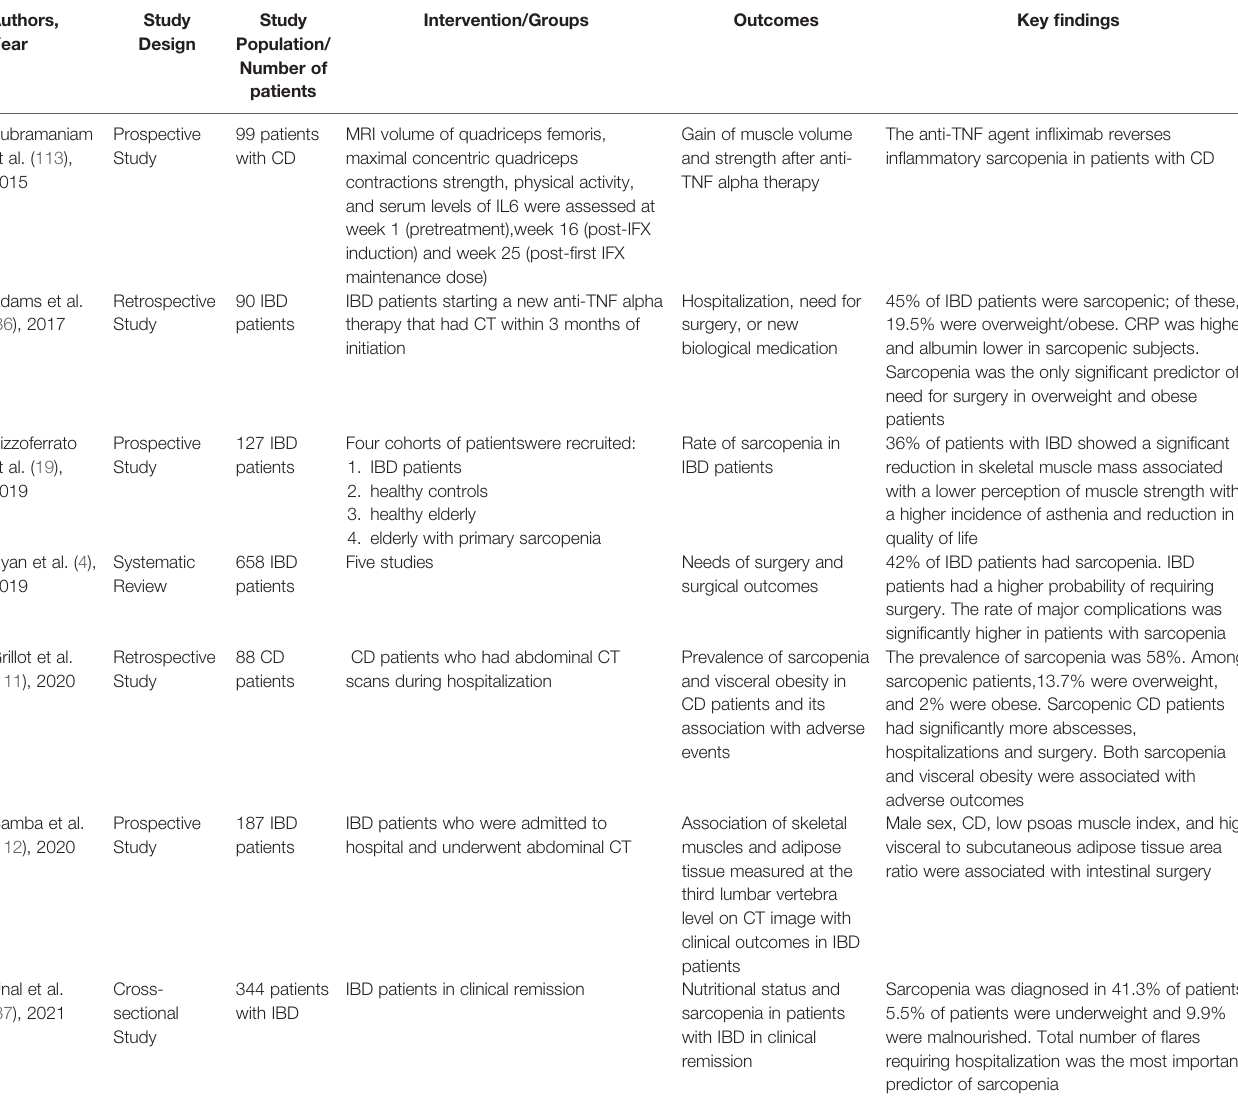
TABLE 1 | Principal human studies that explored the relationship between in fl ammatory bowel diseases and